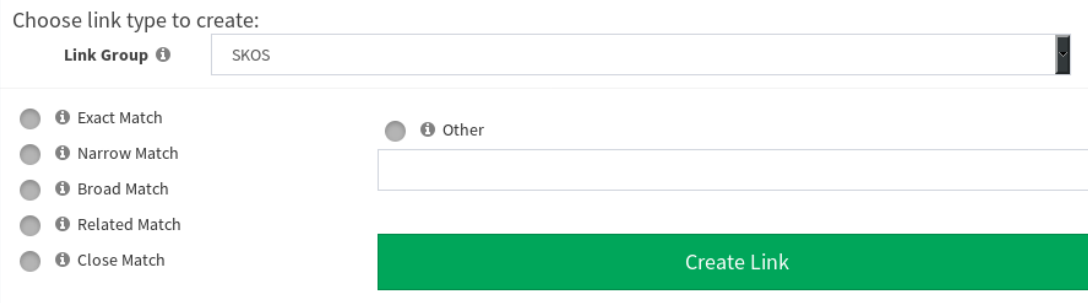
Figure 7. Link Type Selection and Link Creation Module. The user can provide a custom link type by selecting the “Other” option and define the link type on the respective field.